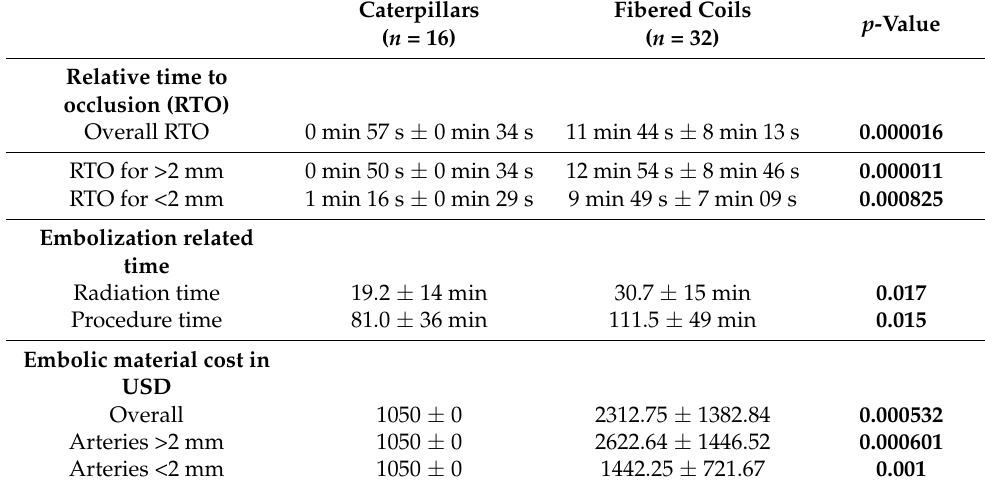
Table 2. Comparison of embolization